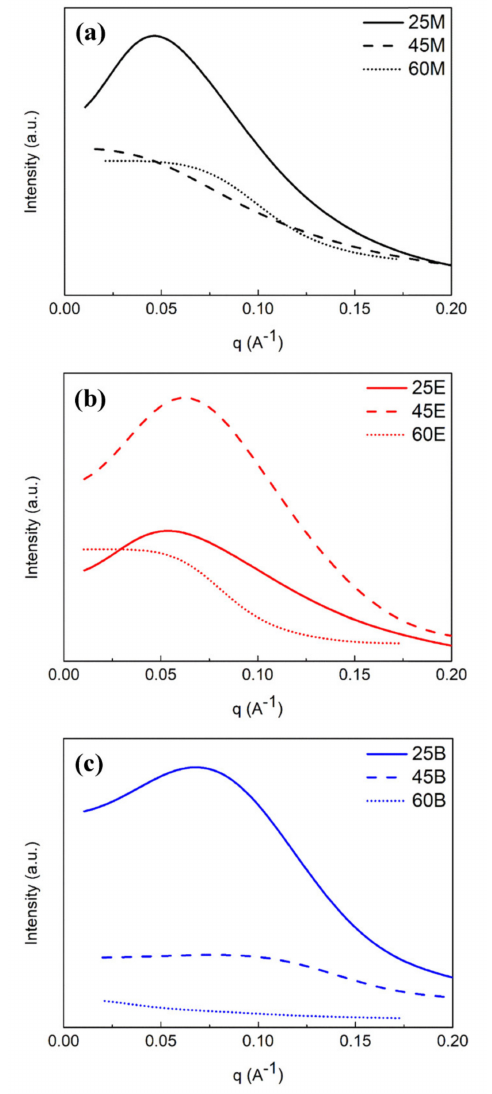
Figure 11. Pore correlation pattern GISAXS in-plane intensity versus q xy for: ( a ) 25 / 45 / 60M; ( b ) 25 / 45 / 60E; ( c ) 25 / 45 / 60B hybrid organosilicate glass